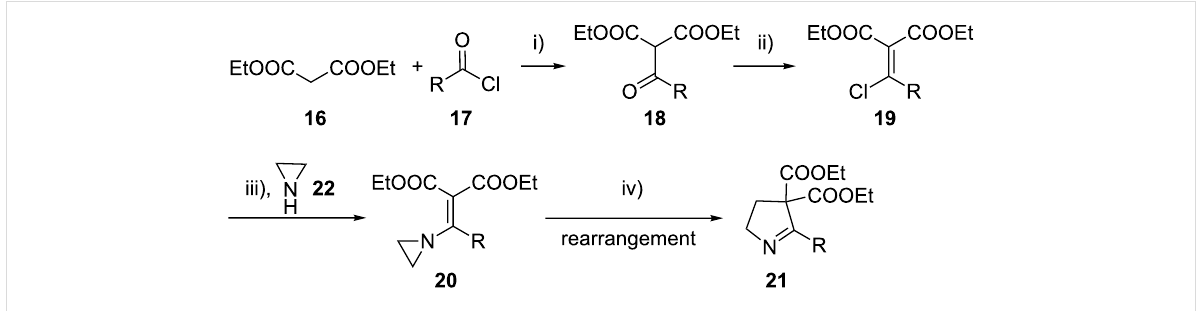
Scheme 2: Synthesis of N- vinyl substituted aziridines and their ring expansion to pyrrolines. Reagents and conditions: i) MgCl 2 , CH 3 CN, TEA, 0 °C, then rt overnight; ii) POCl 3 , n -Bu 3 N, reflux; iii) THF, rt; iv) NaI, acetone, rt,